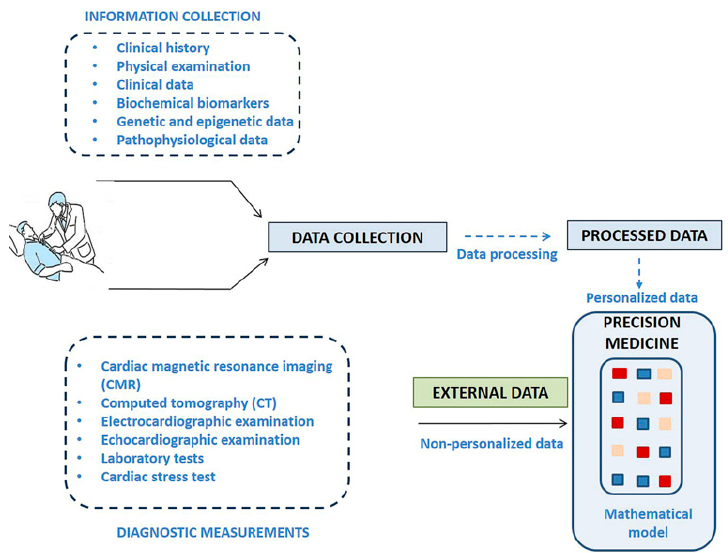
Figure 2. Precision Medicine workflow. The process involves multiple sources of heterogeneous data, including experimental evidence, bioinformatics databases, lifestyle measurements, imaging, and environmental influences, among others. All of them are analyzed through a system integration that incorporates a mathematical model using machine-learning algorithms to identify potential biomarkers and disease networks quickly and accurately, stratify patients and, ultimately, predict more efficacious therapies.